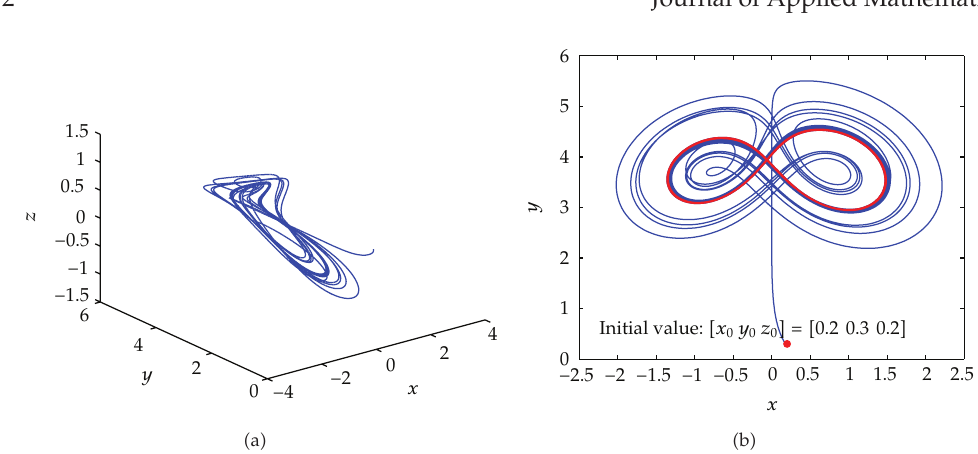
Figure 6: The numerical solutions of Example 4.2 with initial value (cid:3) x 0 ,y 0 ,z 0 (cid:4) (cid:7) (cid:3) 0 . 2 , 0 . 3 , 0 . 2 (cid:4) and step size h (cid:7) 0 . 02: quasiperiodic trajectory (cid:3)(cid:3) a (cid:4) 3D portrait; (cid:3) b (cid:4) x - y projection (cid:4) .